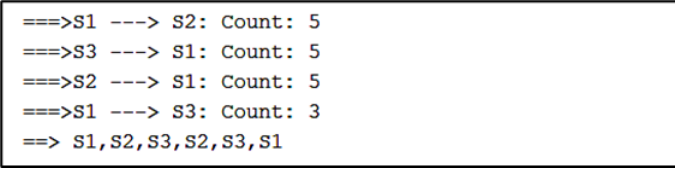
Figure 14. Algorithm 2’s output for Path Figure 13. Algorithm 2 ’ s visualization of Path 2 vectors.